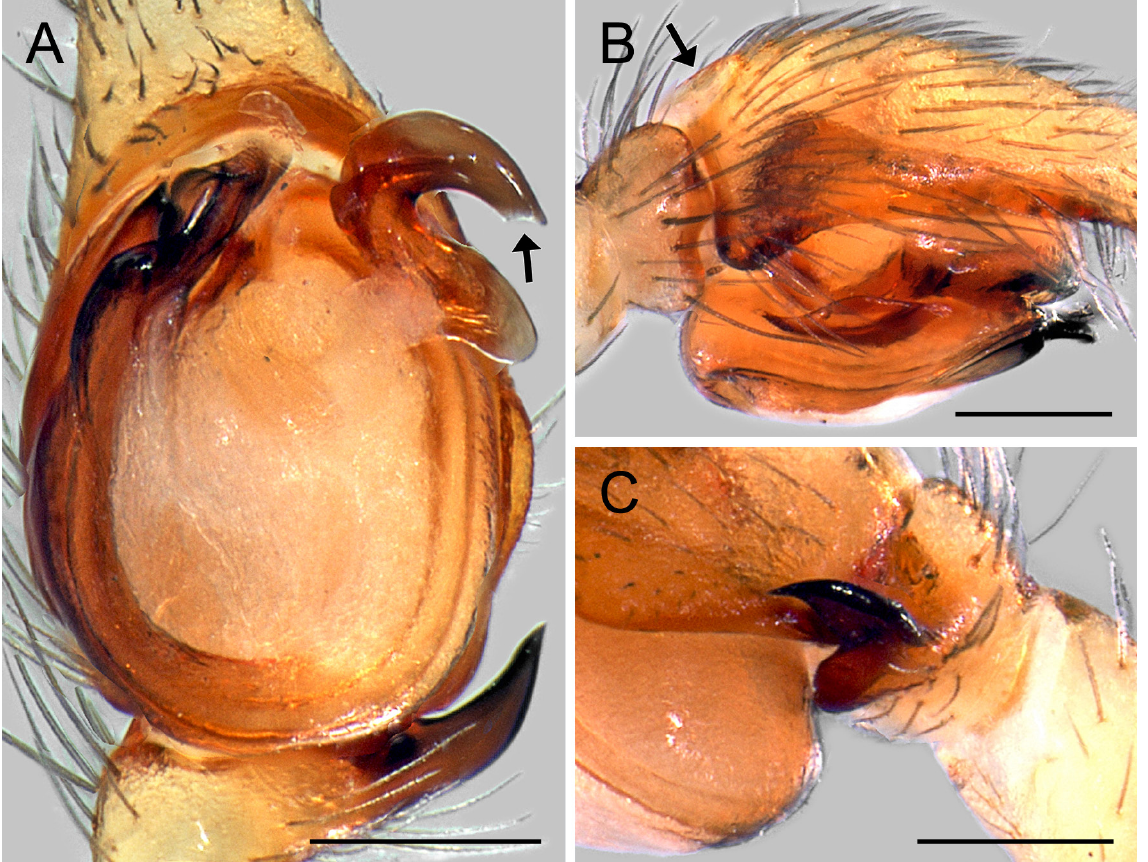
Fig. 8. Acanthinozodium sahelense sp. nov., ♂ from Faro Game Reserve (MRAC 221205), palp. A . Detail of bulbus with MA in expanded position, ventral view; arrow indicates the indentation of the MA tip. B . Tibia and base of bulbus, prolateral view; arrow indicates position of the crater-like plug pit. C . Retrolateral view. Scale bars = 0.2